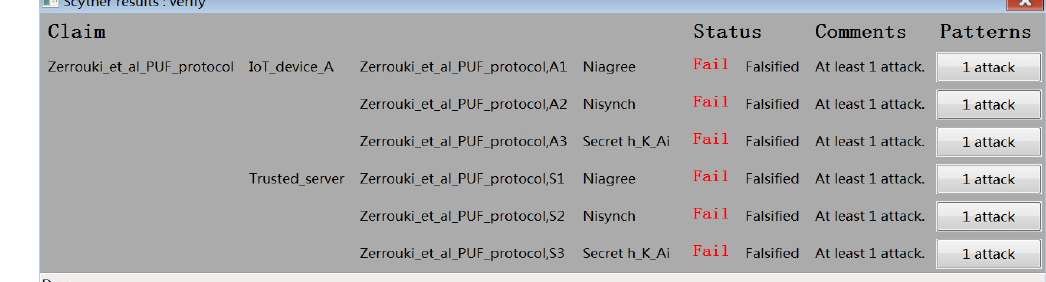
Figure 8. Scyther outputs for Zerrouki et al.’s PUF protocol.